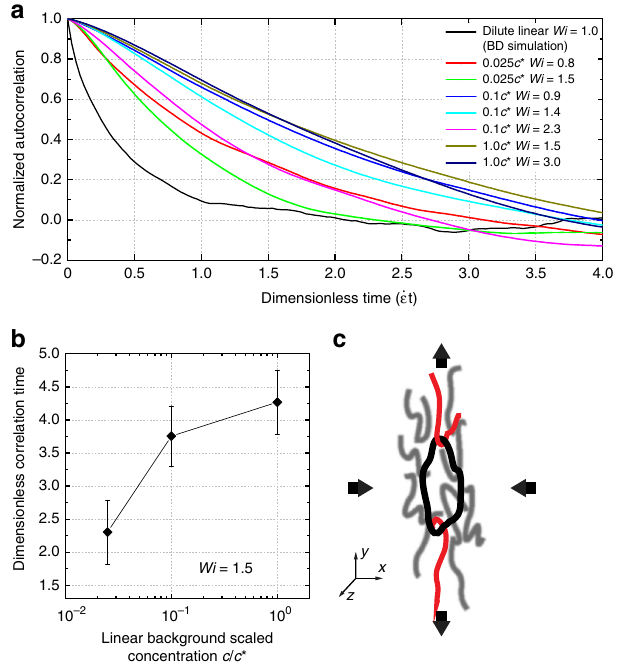
Fig. 6 Quantitative analysis of ring polymer conformational fl uctuations. a Autocorrelation of fl uctuations in ring polymer extension as a function of Wi and background concentration after the initial transient phase. Molecular ensembles consist of n = 200 molecules for dilute linear chains (black solid line); n = 32 and n = 31 for Wi = 0.8 (red solid line) and Wi = 1.5 (green solid line) at 0.025 c * ; n = 24, n = 25, and n = 33 for Wi = 0.9 (blue solid line), Wi = 1.4 (cyan solid line), and Wi = 2.3 (magenta solid line) at 0.1 c * ; n = 38 for Wi = 1.5 (dark yellow solid line) and Wi = 3.0 (navy solid line) at 1.0 c * . b Characteristic correlation time (black diamond) of ring polymer fl uctuations at Wi = 1.5 as a function of background solution concentration. Error bars represent standard deviation. Molecular ensembles consist of n = 31, n = 25, n = 38 molecules, respectively from 0.025 c * to 1.0 c * . c Schematic of two linear polymers threading into a ring polymer in planar extensional fl ow. Source Data are provided as a Source